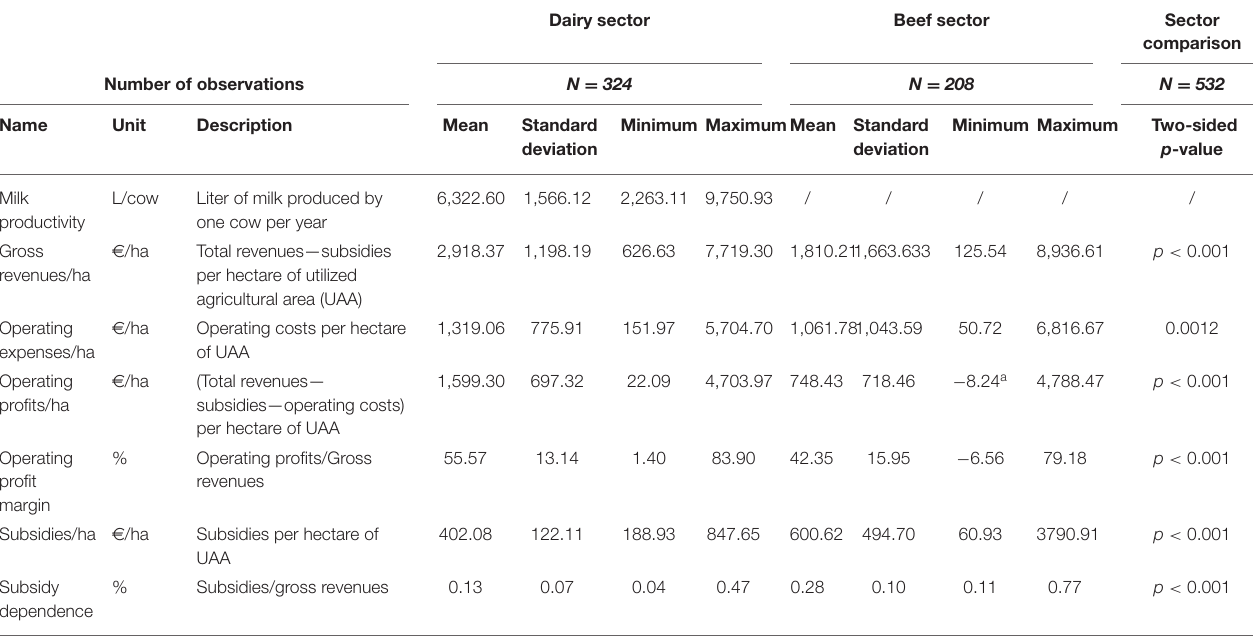
TABLE 1 | Summary statistics of dependent